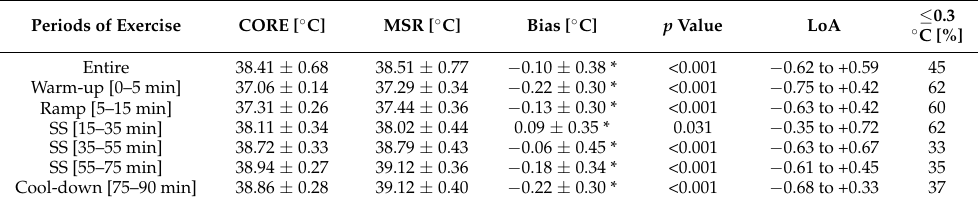
Table 5. Mean core body temperatures indicated by the CORE (first column) and MSR rectal (second column) sensors for the protocol during Study II, as well as the individual phases of this exercise. In addition, the third column represents the mean bias, the fifth limits of agreement (LoA), and the sixth the proportion of all individual measurements ofr which the LoA was less than the pre-defined threshold of 0.3 ◦ C.